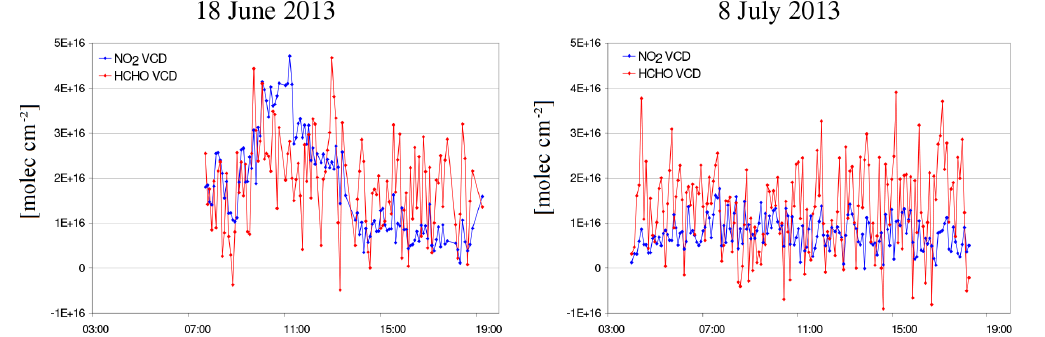
Figure A1. Tropospheric VCDs of NO 2 (blue) and HCHO (red) derived from measurements at 30 ◦ elevation using the geometric approxi-